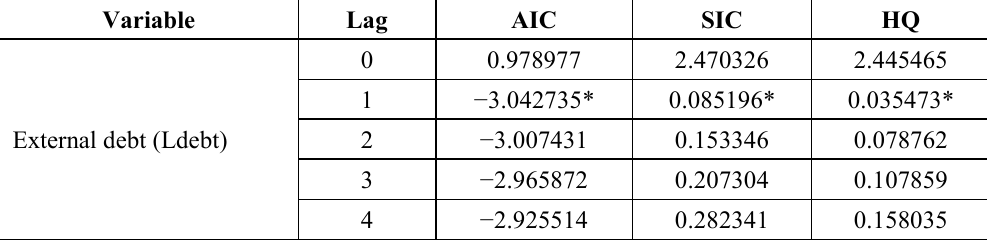
Table 5 . Optimal Lag Selection Result for External Debt